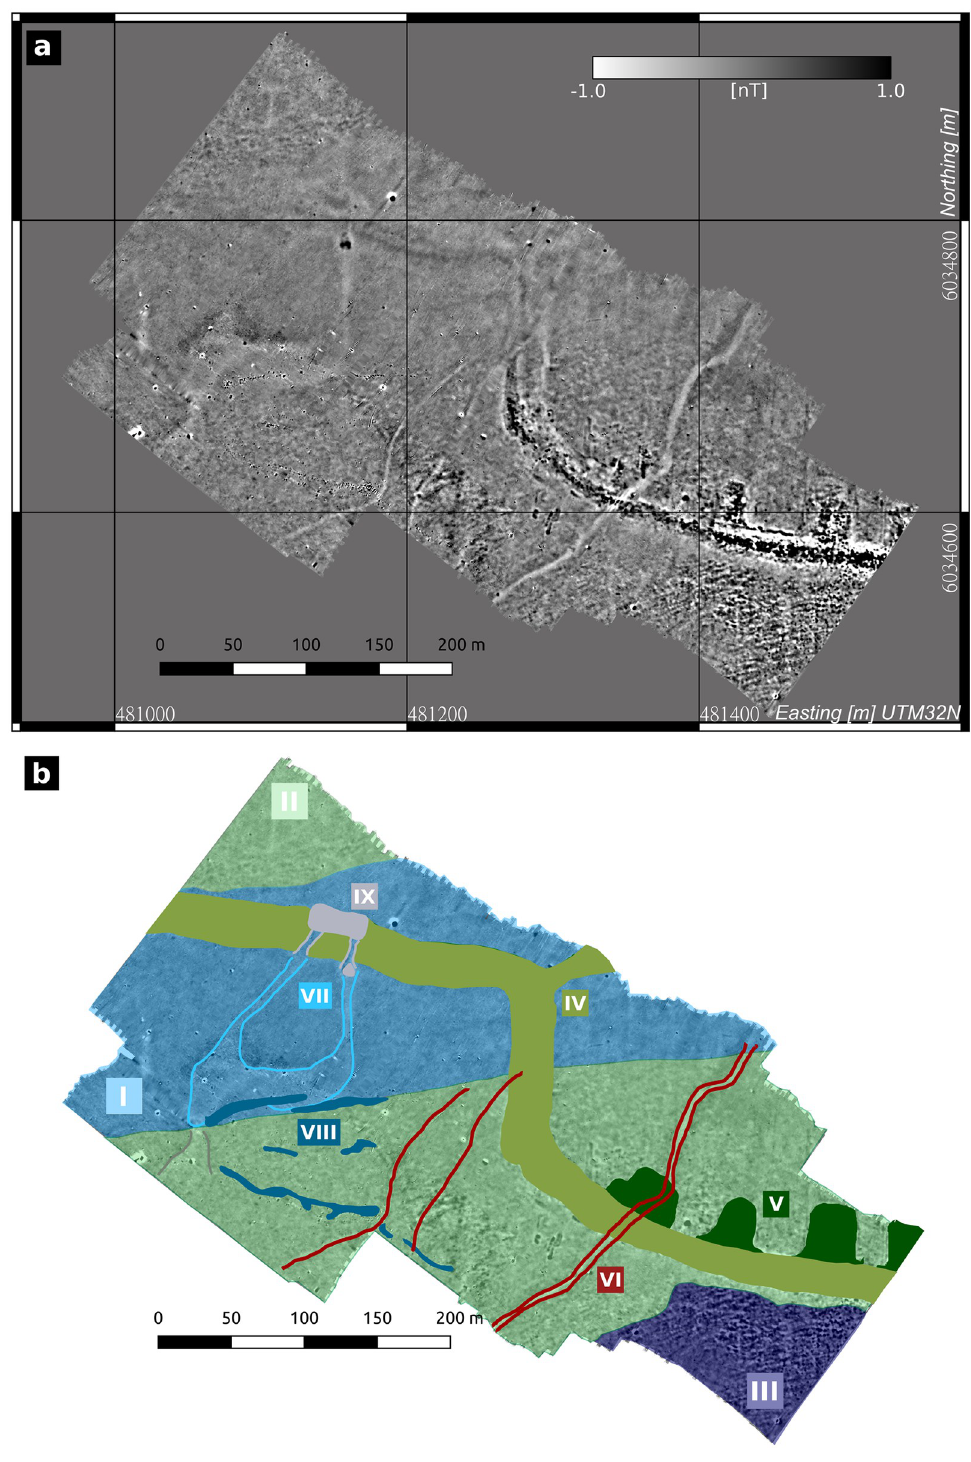
Fig 4. Results of the magnetic gradiometry. a) Magnetic gradient map of the tidal gate and western dyke covering the part of the investigation area that was accessible by walking. b) Redrawing of the magnetic map showing the observed main features. Colored areas and lines correspond to roman feature numbers placed in boxes with equal color. I, area of reduced magnetic signal amplitude compared to the areas II and III; IV, elongated structure, related to the dyke; V, signatures that are connected to the inner side of the dyke; VII, anomalies connected to the tidal gate position that is probably related to I; VI elongated anomalies with no corresponding structures in the recorded observations.